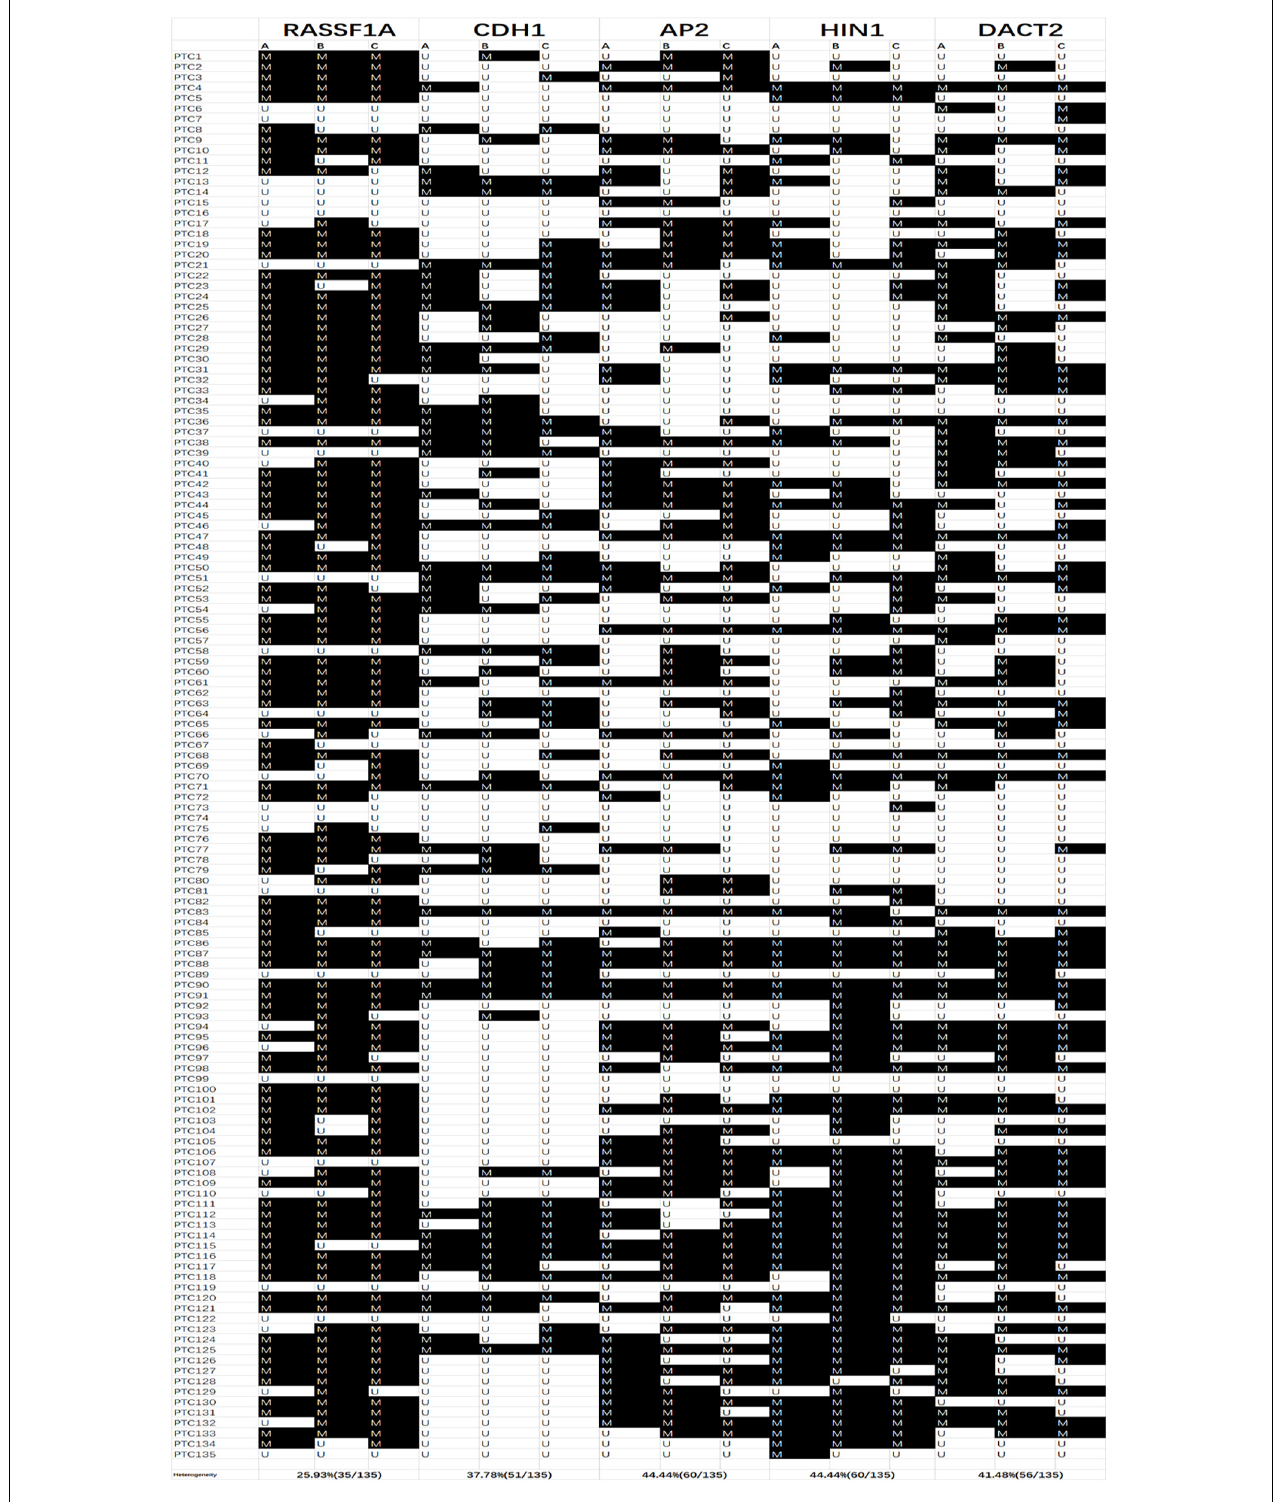
FIGURE 2 | Methylation pattern of 3 different samples for each patient. M, methylation; U, unmethylation; Colum (A–C) are 3 different samples for each case; PTC, papillary thyroid cancer.